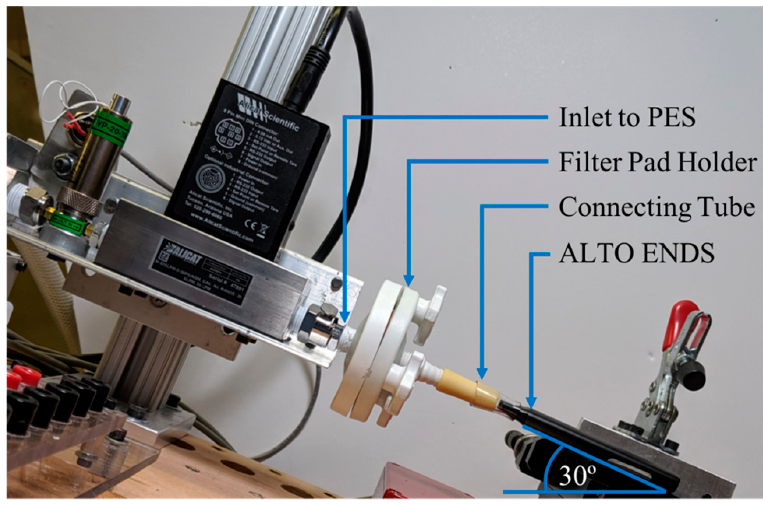
Figure 1. PES-1 setup with ALTO connected to it at 30° angle through a filter pad holder.